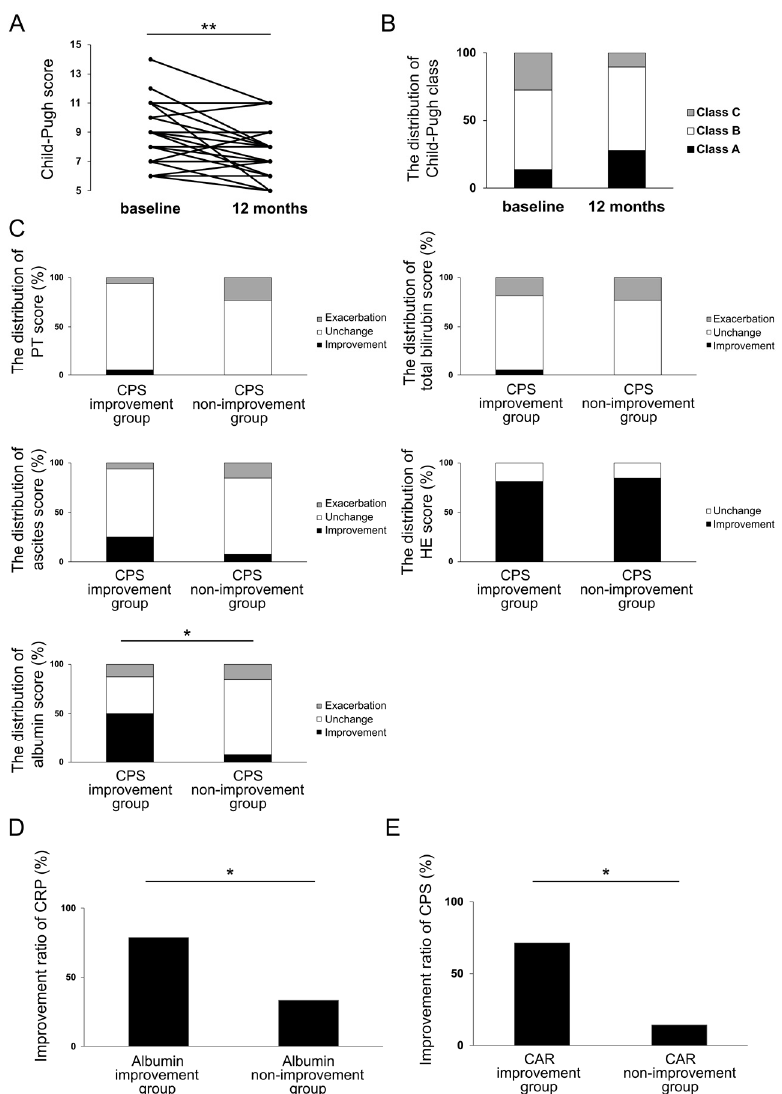
Figure 5. CPS ( A ) and the distribution of Child–Pugh class ( B ) at 12 months of rifaximin administration. The distribution of changes in CPS parameters in CPS improvement group and CPS non-improvement group at 12 months of rifaximin administration ( C ). Improvement ratio of CRP levels in albumin improvement group and albumin non-improvement group at 12 months of rifaximin administration ( D ). Improvement ratio of CPS at 12 months of rifaximin administration in CAR improvement group and CAR non-improvement group at 3 months ( E ). * p < 0.05, ** p < 0.01. CAR, CRP to albumin ratio; CPS, Child–Pugh score; CRP, C-reactive